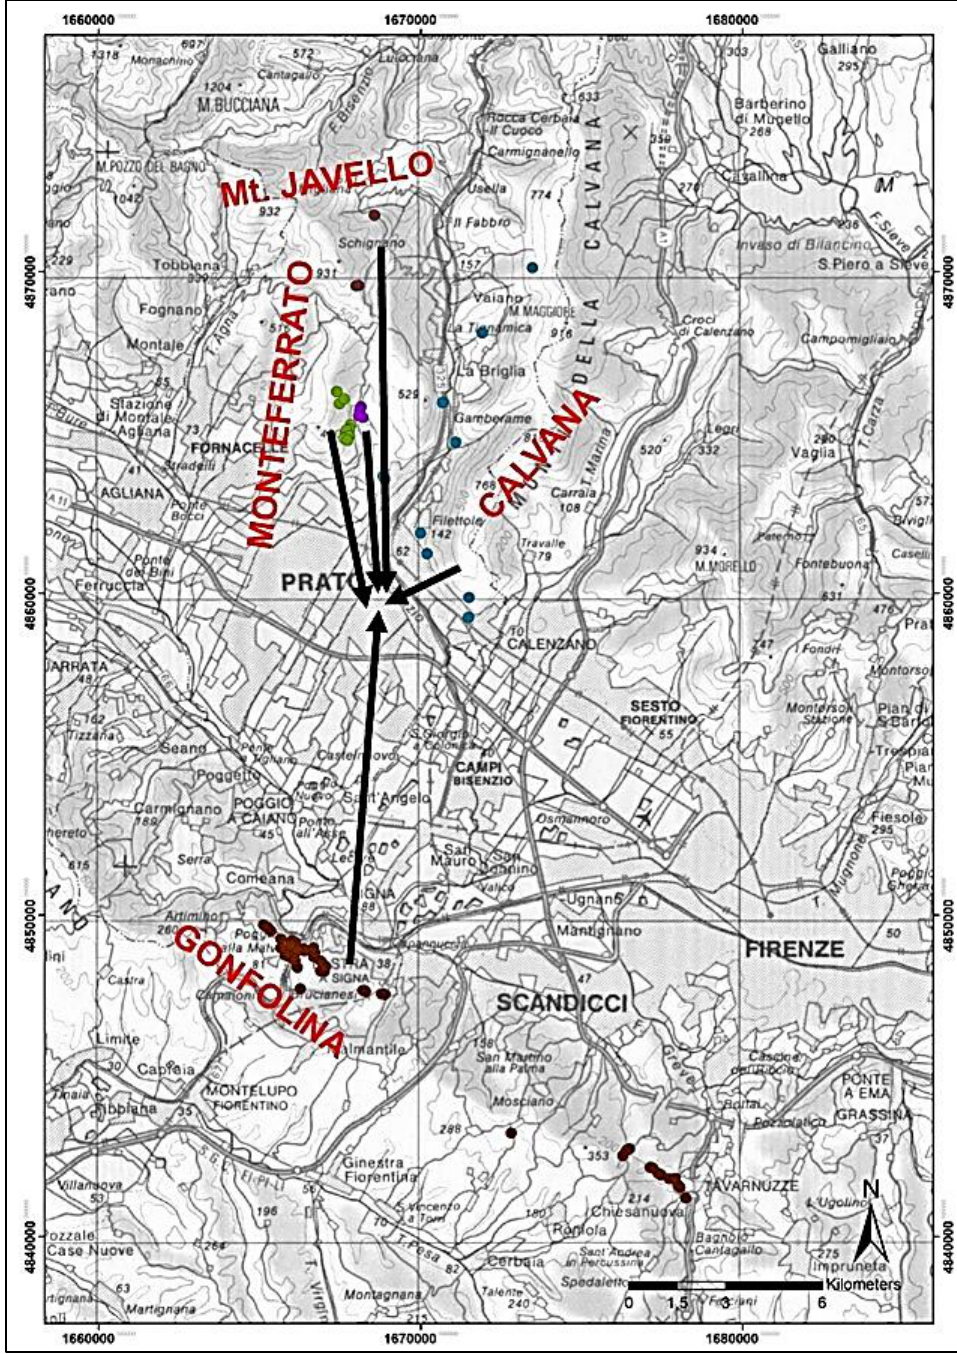
Figure 6. Historical quarries of the Prato territory that supplied the building stones for the Cathedral and Bell Tower: green Verde Prato, brown Pietra Serena, blue Alberese, purple Palombino (Gauss- Boaga Ovest reference system).